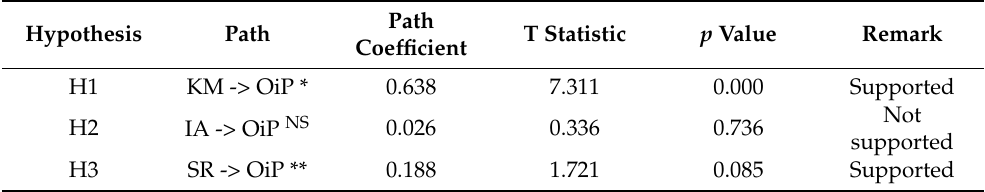
Figure 3. The structural model with t-statistic values. Table 9. Structural model testing.